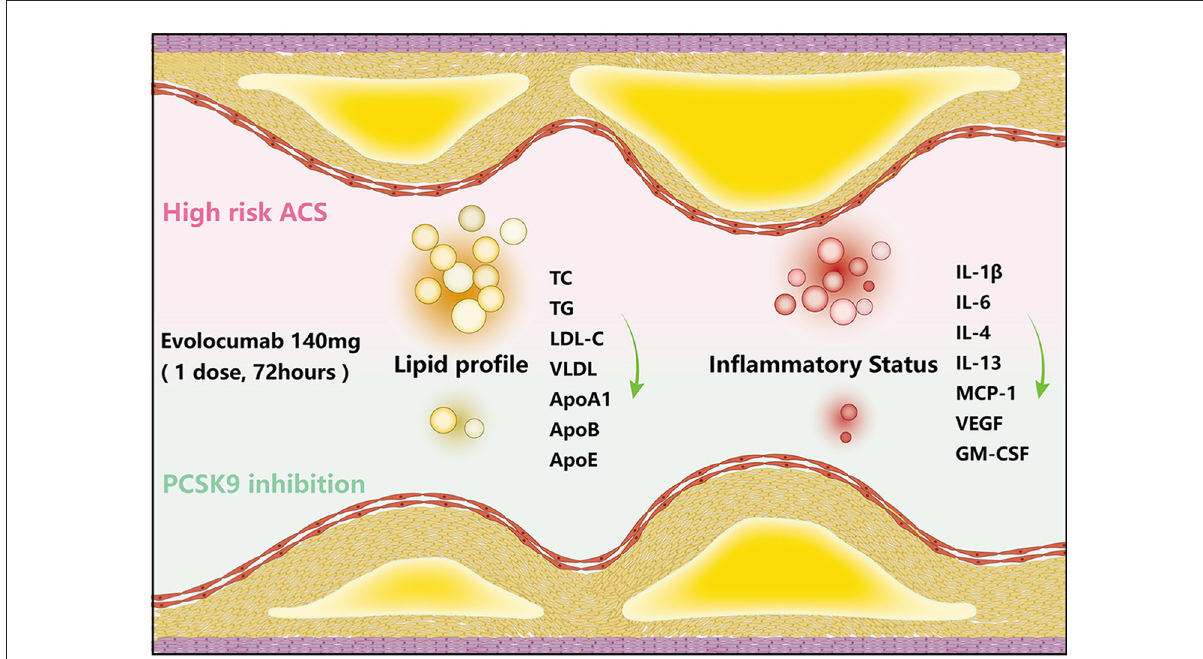
FIGURE5 Short-term LDL-C-lowering efficacy of evolocumab in AMONG-US study and schematic diagram. Schematic diagram of the lipid-lowering and inflammation-regulating effects of evolocumab. The levels of TG, TC, LDL-C, sdLDL-C, ApoA1, ApoB, and ApoE, as well as the circulating levels of IL-1 β , IL-6, IL-4, IL-13, MCP-1, VEGF, and GM-CSF, decreased at 72h post-evolocumab administration compared with baseline in patients with